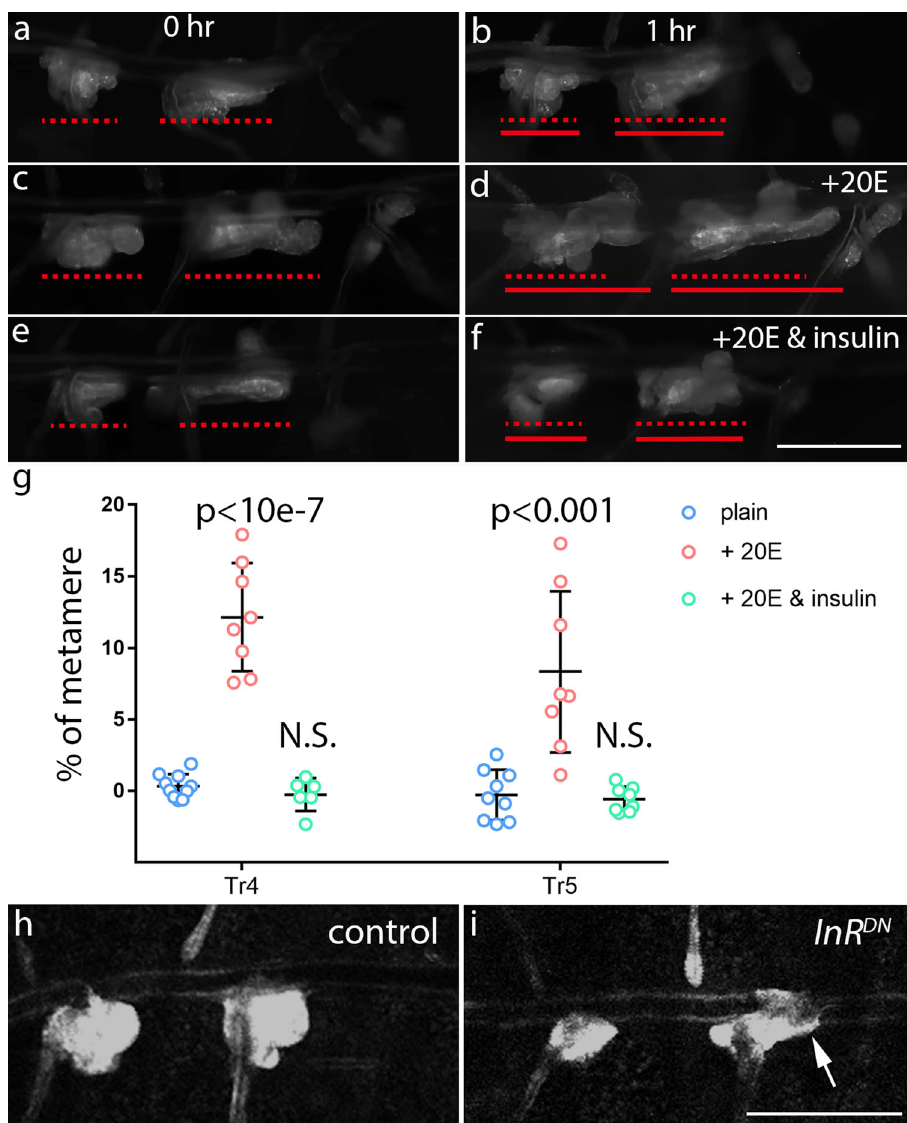
Fig. 5 The effects of insulin on progenitor migration. a – d An ex vivo culture condition with a key supplement of steroid hormone 20-hydroxyecdysone (20E) was suf fi cient to preserve the migration of tracheal progenitors. e , f Exogenous insulin prevents the migration of tracheal progenitors. Pupal trachea in Grace ’ s Insect Medium (GIM) ( a , b ), ecdysone (20E) plus GIM ( c , d ) and ecdysone (20E) plus GIM with insulin ( e , f ). The positions of progenitors at 0 h APF and 1 h APF are indicated by dashed lines or solid lines, respectively. g Scatter plot depicting migration distance of tracheal progenitors. Five biologically independent experiments were performed. Tr4: plain ( n = 10), 20E ( n = 8; p = 4.47e-8), 20E&insulin ( n = 6; p = 0.253). Tr5: plain ( n = 9), 20E ( n = 8; p = 5.48e-4), 20E&insulin ( n = 6; p = 0.669). Data are presented as mean values ± SD. N.S. not signi fi cant. Unpaired two-tailed t -test was used for all statistical analyses. No adjustments were made for multiple comparisons. h , i Reduced insulin activity promotes migration of tracheal progenitors. Lowering insulin activity by expressing InR DN for 20 h in L3 triggered early migration of tracheal progenitors in white pupae. Five independent experiments were repeated with similar results. Arrow denotes the progression of progenitors on dorsal trunk. Scale bars: 200 μ m ( a – f , h , i ). Genotypes: ( a – f ) P[B123]- RFP-moe/ + ; ( h ) btl-Gal4/ + ; tub-Gal80 ts / P[B123]-RFP-moe ; ( i ) btl-Gal4/UAS-InR DN ; tub-Gal80 ts / P[B123]-RFP-moe . Source data for ( g ) are provided as a Source Data fi